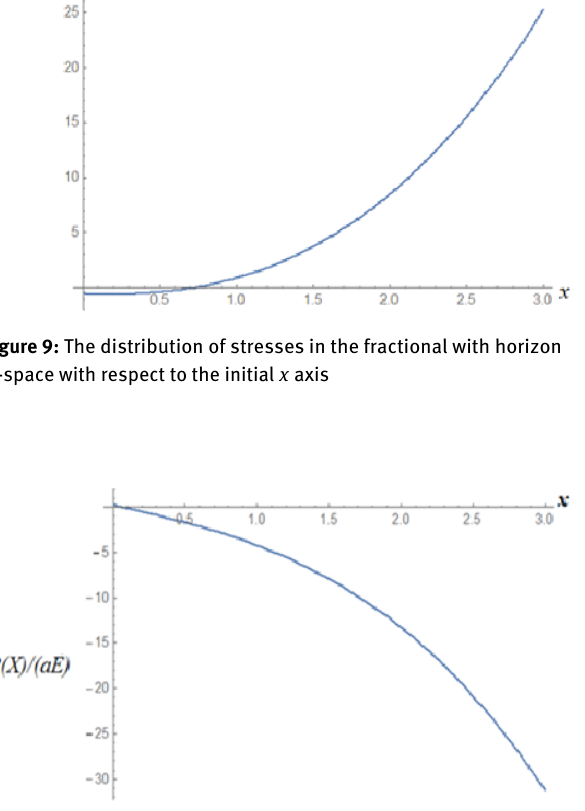
Figure 10: The distribution of body forces in the fractional with horizon Λ -space with respect to the initial x